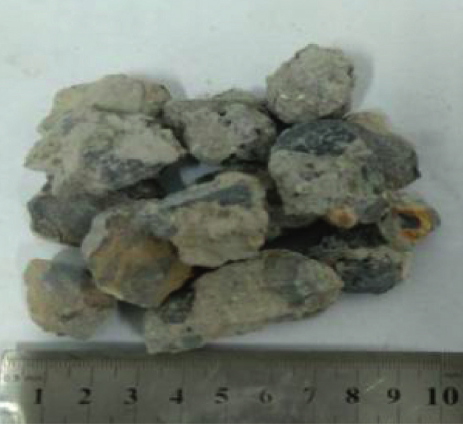
Figure 1: Recycled coarse